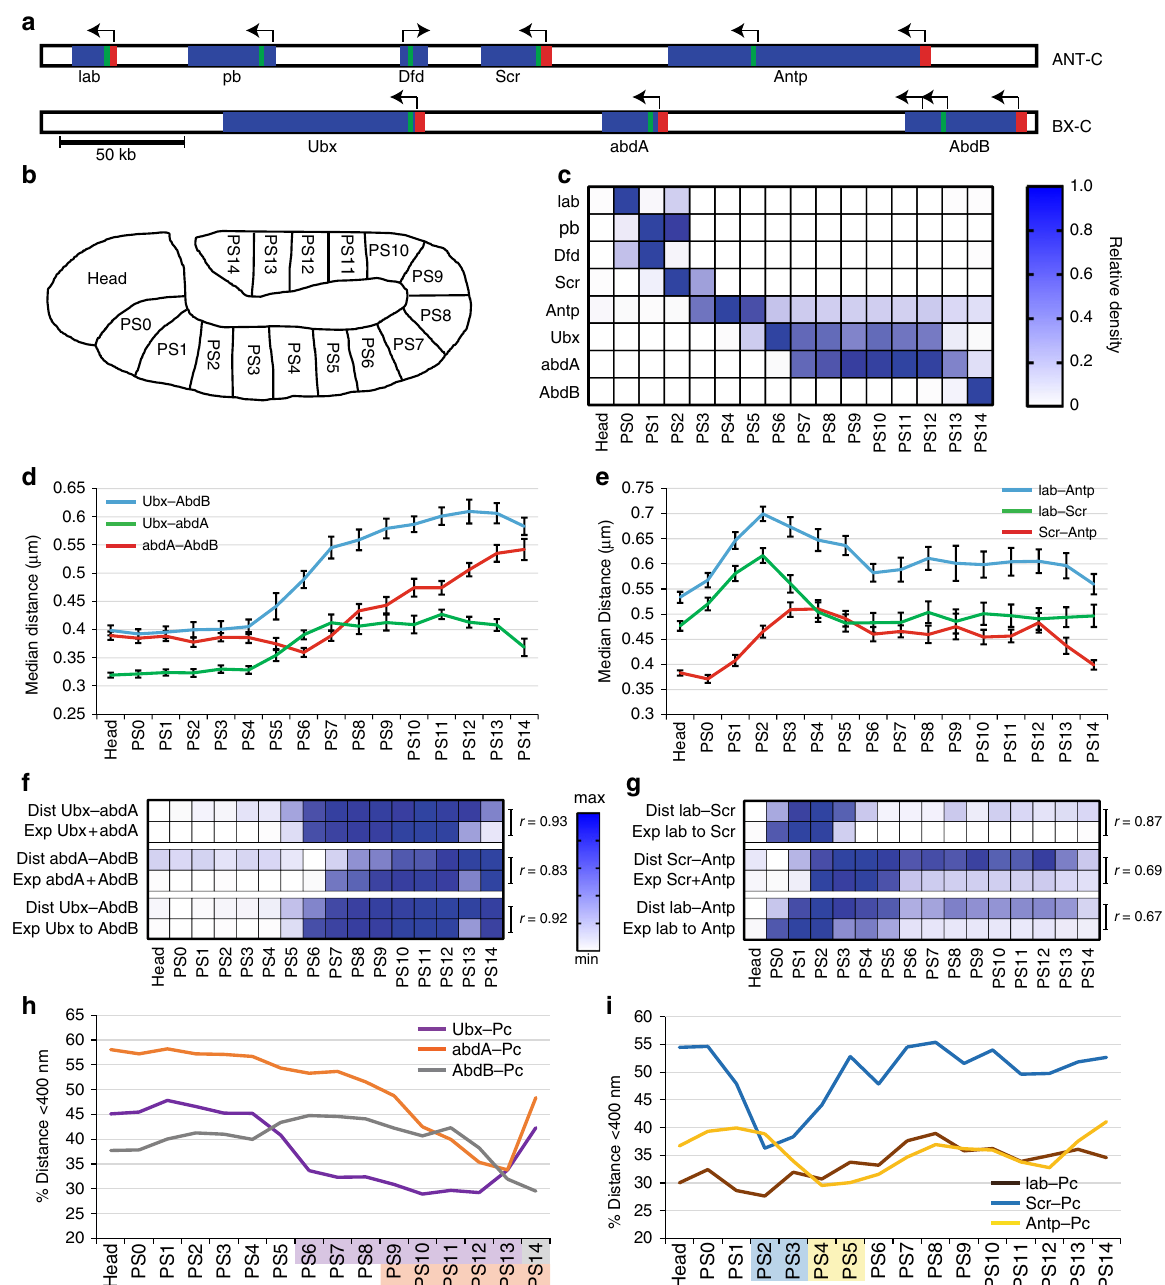
Fig. 1 Hox gene expression correlates with Hox cluster chromatin opening. a Schematic representation of ANT-C and BX-C (Hox genes in blue, positions of DNA FISH probes in red, and positions of RNA FISH probes in green; the arrows show promoters). b Schematic diagram depicting the PSs of Drosophila embryos in which measurements were performed. c Relative density of RNA FISH spots measured for each Hox gene along the anteroposterior axis of WT Drosophila embryos 3:50 – 7:20 after fertilization. The density of RNA FISH spots is calculated by dividing the number of spots by the area of the PS. d , e Distances between the promoters of Ubx , abdA , and AbdB (d) or lab , Scr , and Antp (e) measured within cell nuclei of WT Drosophila embryos 3:50 – 7:20 after fertilization along the anteroposterior axis. We calculated distances between centroids of DNA FISH spots in three dimensions. For each PS of one embryo, we computed the median distances Ubx – abdA , abdA – AbdB , Ubx – AbdB or lab – Scr , Scr – Antp , lab – Antp . Curves represent the average median distances measured in several embryos and the corresponding error bar (SEM; N ≥ 16). f , g Heat maps showing correlations between Hox gene transcription and chromatin opening in the BX-C ( f ) and the ANT-C ( g ). The physical distance (Dist) between two loci within a Hox complex measured the chromatin opening and Hox gene expression (Exp) is calculated by adding the relative density of RNA FISH spot of Hox genes comprised between these two loci. All measurements were normalized between their minimum and their maximum. r indicates correlation coef fi cients. h , i Distances between promoters of Ubx , abdA , and AbdB (h) or lab , Scr and Antp (i) and the closest Polycomb foci were measured in WT Drosophila embryos 3:50 – 7:20 after fertilization. The percentage of distances measuring less than 400 nm was calculated for each PS of one embryo. Curves represent the mean percentage measured in several embryos. The highlighted PSs show regions wherein Hox genes were found to be signi fi cantly further away from Pc foci than in Head- PS0 ( t -test, one-tailed, P < 0.01; Ubx in violet, abdA in orange, and AbdB in gray; Scr in blue and Antp in